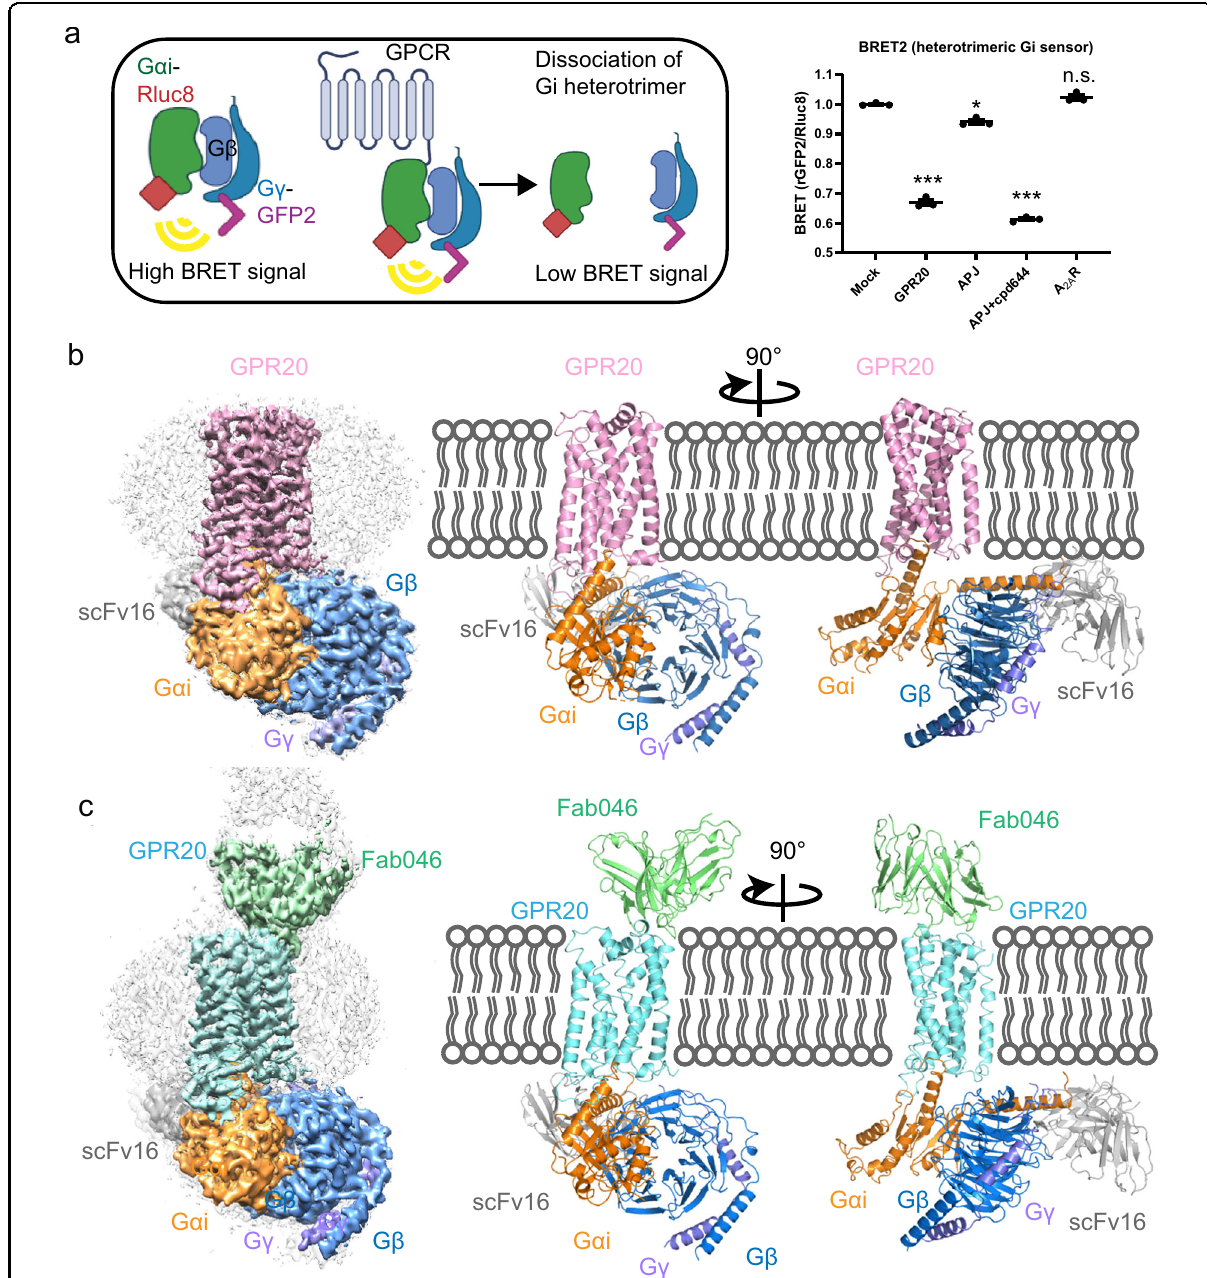
Fig. 1 Cryo-EM structure of the ligand-free GPR20-Gi complex. a Left, schematic diagram of the bioluminescence resonance energy transfer (BRET2) assay to measure Gi heterotrimer dissociation upon activation. Right, normalized BRET values of HEK293T cells transiently co-transfected with the Gi BRET sensor along with either empty vector (mock control), GPR20, the adenosine A 2A receptor (A 2A R, negative control) or the apelin receptor (APJ, positive control) in the absence and presence of 10 μ M agonist cpd644. Data are normalized to the mock control and represented as the mean ± s.e.m. for n = 3 biologically independent experiments. Signi fi cance was determined by two-way analysis of variance (ANOVA) without repeated measures, followed by Dunnett ’ s post hoc test (*** P < 0.001, * P < 0.05; n.s., not signi fi cant). b Left, cryo-EM density map of the GPR20- G α iG β G γ -scFv16 complex. Right, two orthogonal views of the cartoon representation of the atomic model of the complex. Color coding is annotated for each protein component. c Left, cryo-EM density map of the GPR20-G α iG β G γ -scFv16-Fab046 complex. Right, two orthogonal views of the cartoon representation of the atomic model of the complex. Color coding is annotated for each protein